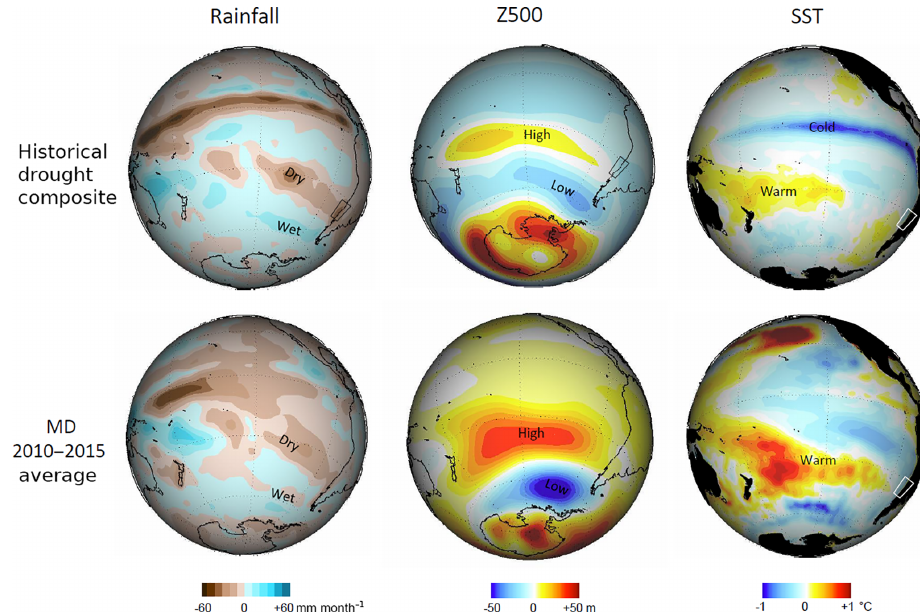
Figure 7. Composite anomaly (departure from the long-term mean) maps of austral winter (MJJAS) precipitation (from the Global Precipita- tion Climatology Project available since 1979), sea surface temperature (SST, from NOAA extended reconstructed sea surface temperatures available since 1860) and 500hPa geopotential height (Z500, from NCEP-NCAR reanalysis available since 1948) during droughts in central Chile. Upper panels: historical droughts according to Table 2 (1948–2009). Lower panels: megadrought period (2010–2015).